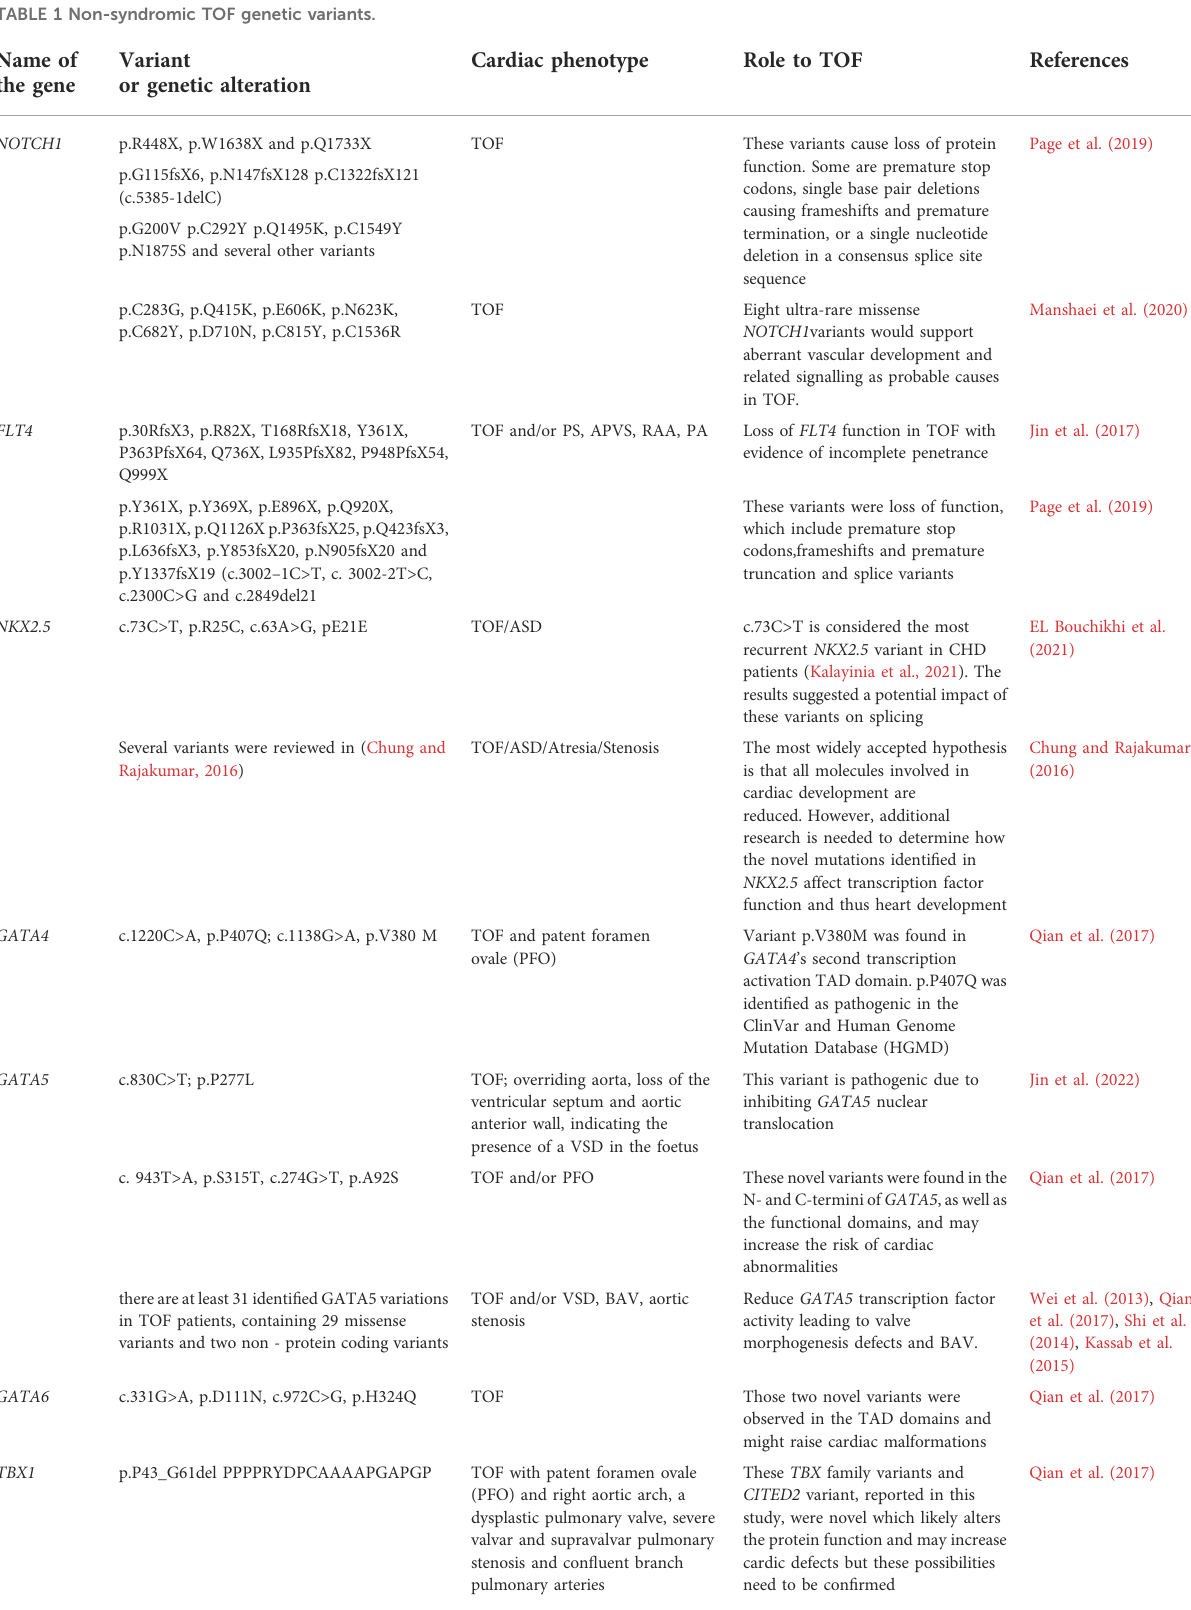
TABLE 1 Non-syndromic TOF genetic